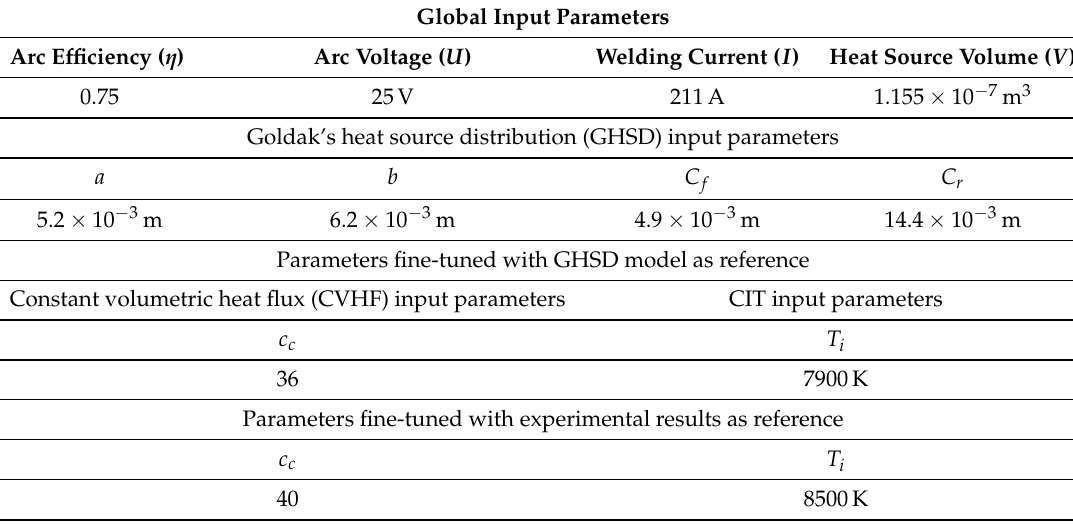
Table 2. Numerical input parameters employed during the calibration of the models.